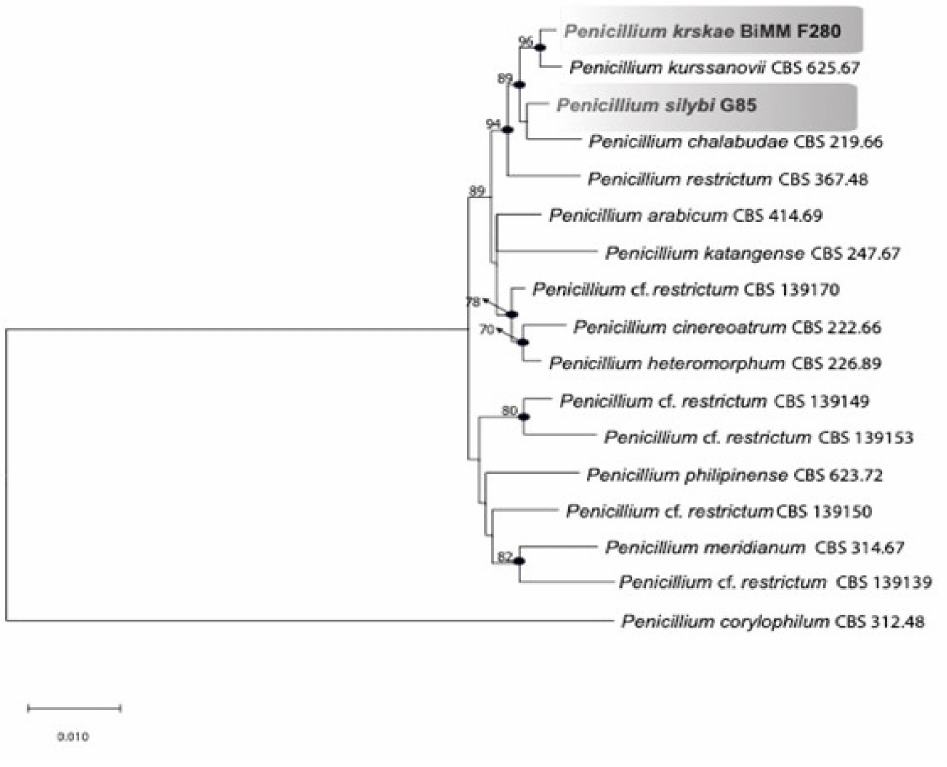
Figure 3. Maximum likelihood tree based on combined BenA , CaM , and RPB2 of P. restrictum -clade within Penicillium section Exilicaulis . Bootstrap values higher than 70 are given above the branches. Penicillium corylophilum CBS 312.48 T was used as an outgroup. Names in bold are new species described in this study. Thickened nodes indicate Bayesian posterior probabilities ≥